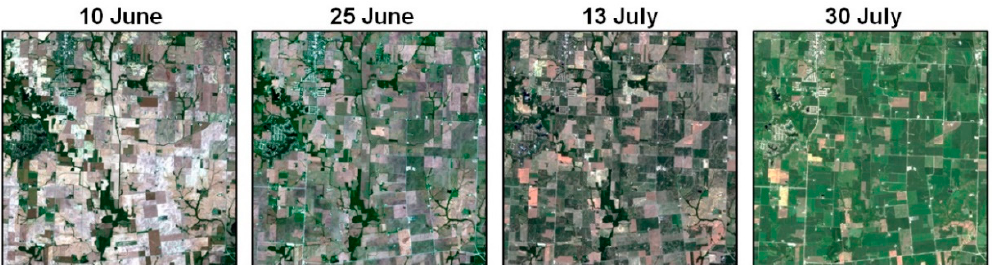
Figure 3. Sentinel-2 true color composite images in the study area.